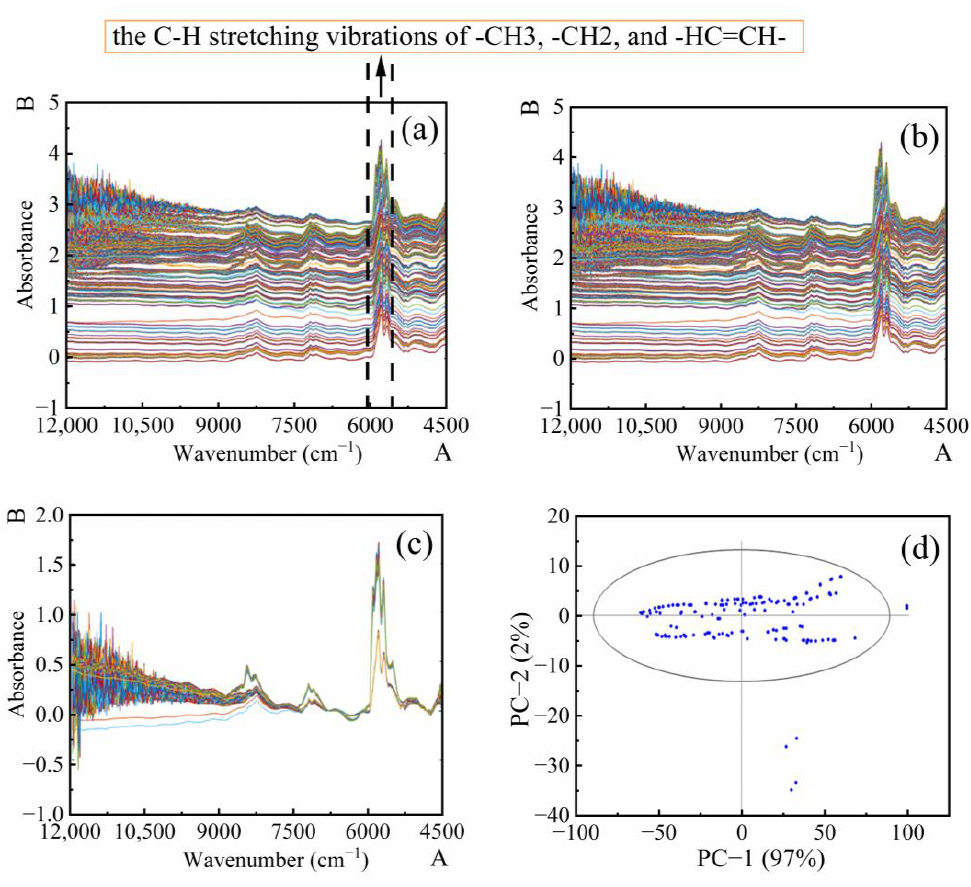
Figure 5. NIR spectra of HBO samples within the range of 12,000 cm − 1 –4500 cm − 1 . ( a ) Raw NIR spectral data. ( b ) Spectra denoised by DWT. ( c ) Spectra after baseline correction. ( d ) Score plot from the PCA of the NIR spectra of the HBO samples.